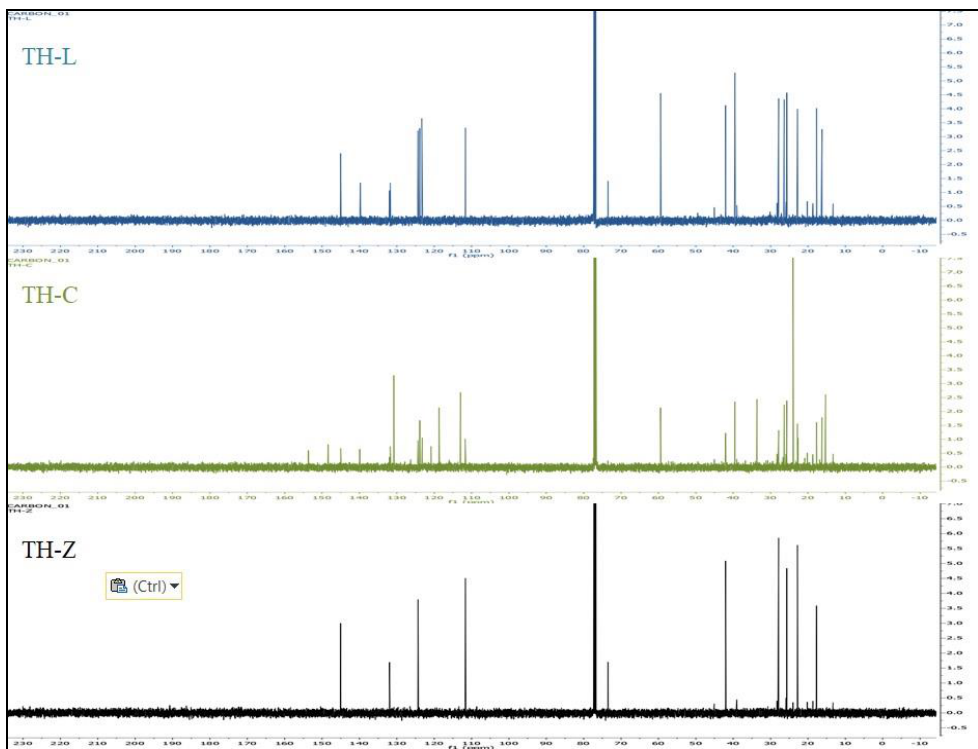
Figure 3. 13 C - NMR from the analysis of the essential oils of Thymus holosericeus collected from three Ionian Islands, Greece (TH-Z: Zakynthos; TH-C: Cephalonia, TH-L: Lefkada) during full-flowering (July 2018).